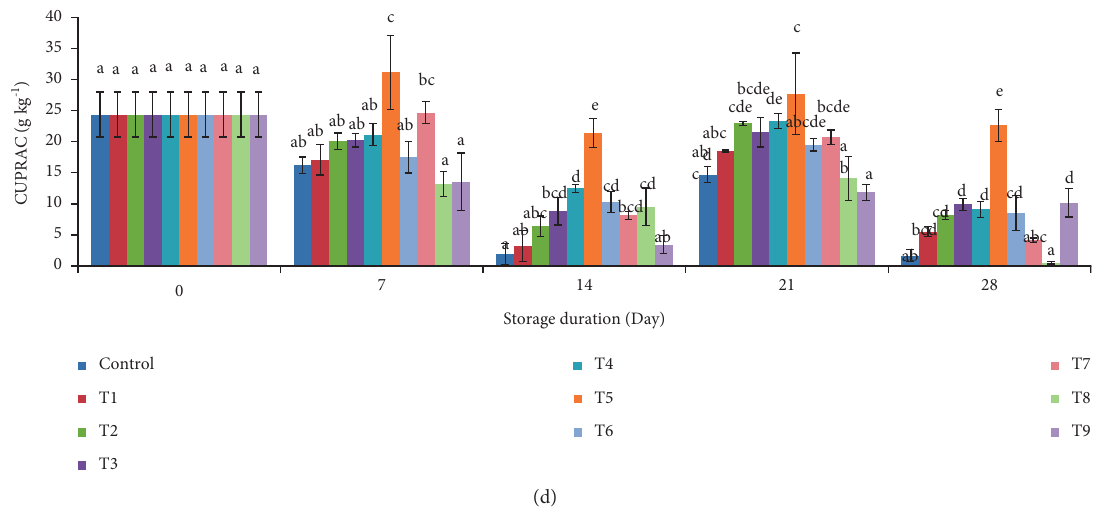
Figure 3: (a) Total phenolic content (TPC), (b) total flavonoid content (TFC), (c) 2,2-diphenyl-1-picrylhydrazyl (DPPH), and (d) cupric reducing antioxidant power (CUPRAC) of peel of mango cv. “Dashehari” treated with melatonin (MT), followed by low-temperature storage at 5 ± 1 ° C. Measurements were taken every 7d of storage, followed by a 3 d of shelf life at room temperature. Each value is the mean of three replicates; vertical bars indicate the standard error. Different lowercase letters on the same storage period indicate a significant difference ( p < 0 . 05) according to Duncan’s multiple range test. The abbreviated treatment details: 0 (control), 50 µ M for 90min (T1), 50 µ M for 120min (T2), 50 µ M for 150min (T3), 100 µ M for 90min (T4), 100 µ M for 120min (T5), 100 µ M for 150min (T6), 150 µ M for 90min (T7), 150 µ M for 120min (T8), and 150 µ M for 150 min